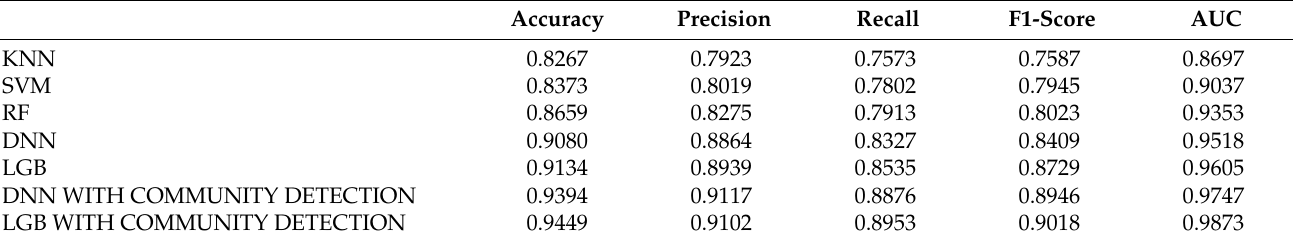
Table 4. Comparison of advantages and disadvantages of three feature selection methods.